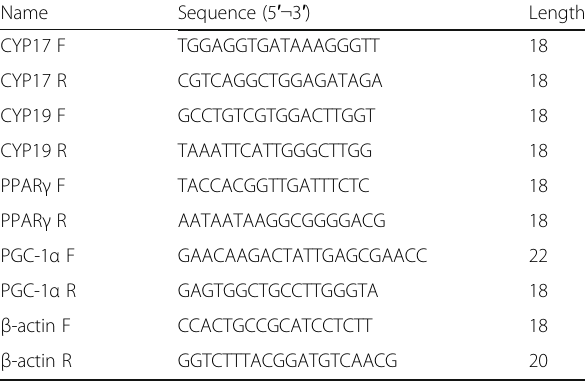
Table 1 Oligonucleotide primer sets for real-time